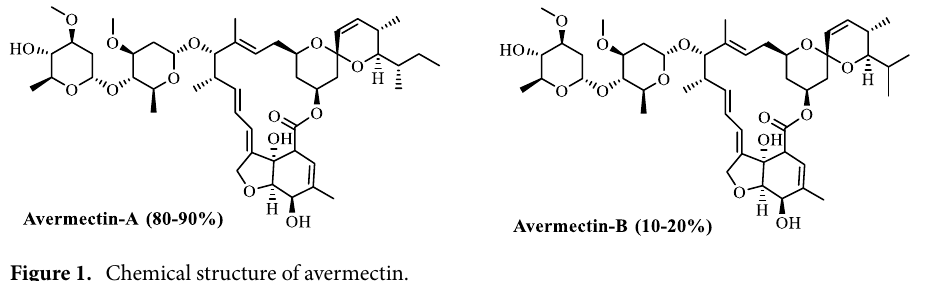
Figure 1. Chemical structure of